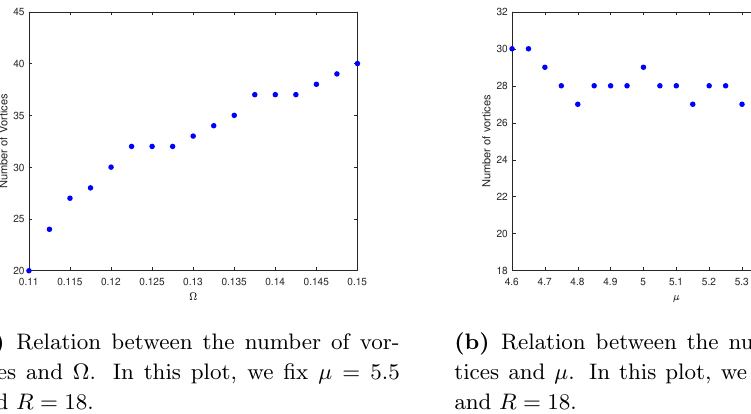
Figure 6. Dependence of the vortex number on other